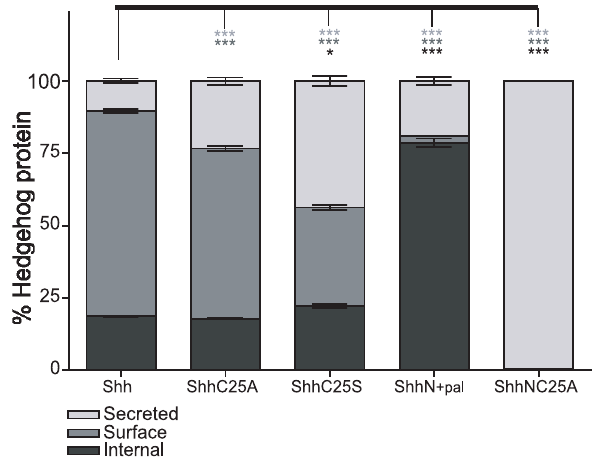
Figure 5. Quantification of the contributions of the lipid moieties to cellular distribution of Shh. Shown are integrated data from ELISA and flow cytometric measurements of recombinant forms of Shh expressed inside cells, on the cell surface, or secreted in the culture medium. The proportion of cell associated and secreted Shh protein for each recombinant expression construct was determined by ELISA measurements of cell lysate and conditioned medium in cells transfected with two fold increments of 62.5–500 ng cDNA (Figure 2B). From the same culture wells, the percentage of Shh protein expressed on the surface and within cells was determined by flow cytometric measurements (Figure 4). To determine the proportion of surface protein expression, the quantity of cell associated Shh was multiplied by the percentage expressed on the cell surface as calculated in Figure 4D. The remaining cell associated Shh protein represents the internal proportion for each recombinant construct. ***, p , 0.001; *, p , 0.05 ( 6 s.e.m.)